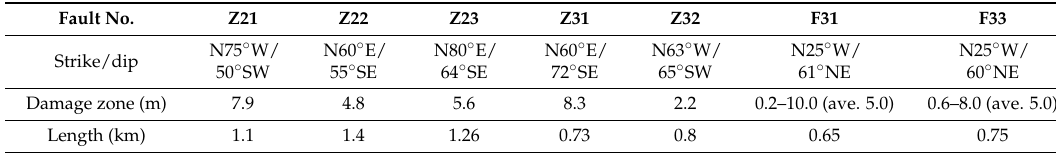
Table 1. Properties of the deterministic faults in the study area.